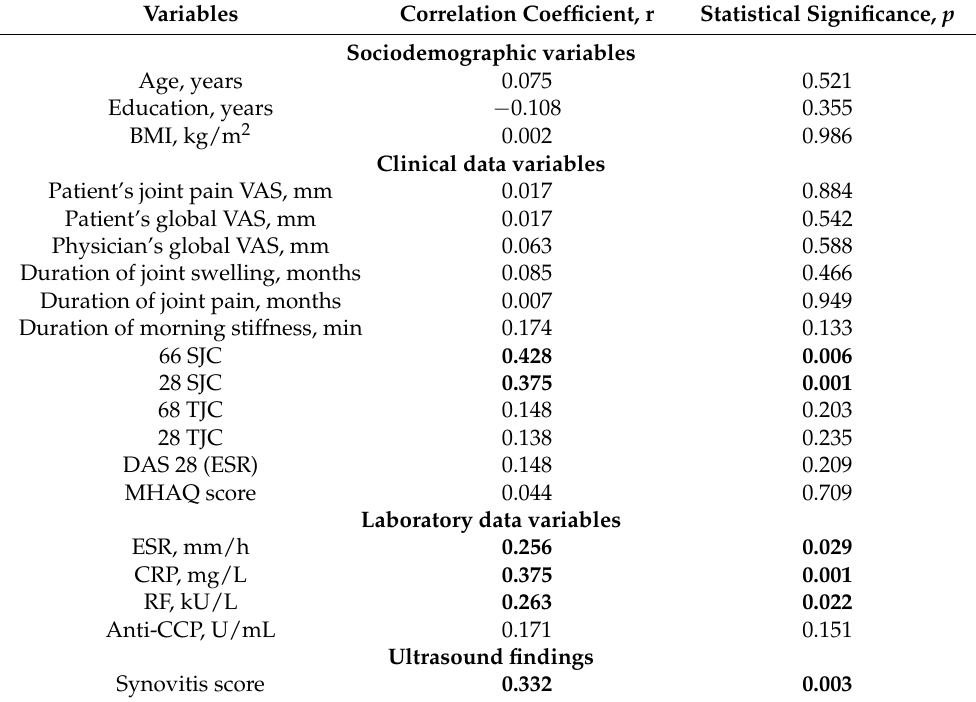
Table 4. VEGF level correlation between early undifferentiated arthritis sociodemographic, clinical, laboratory and ultrasound